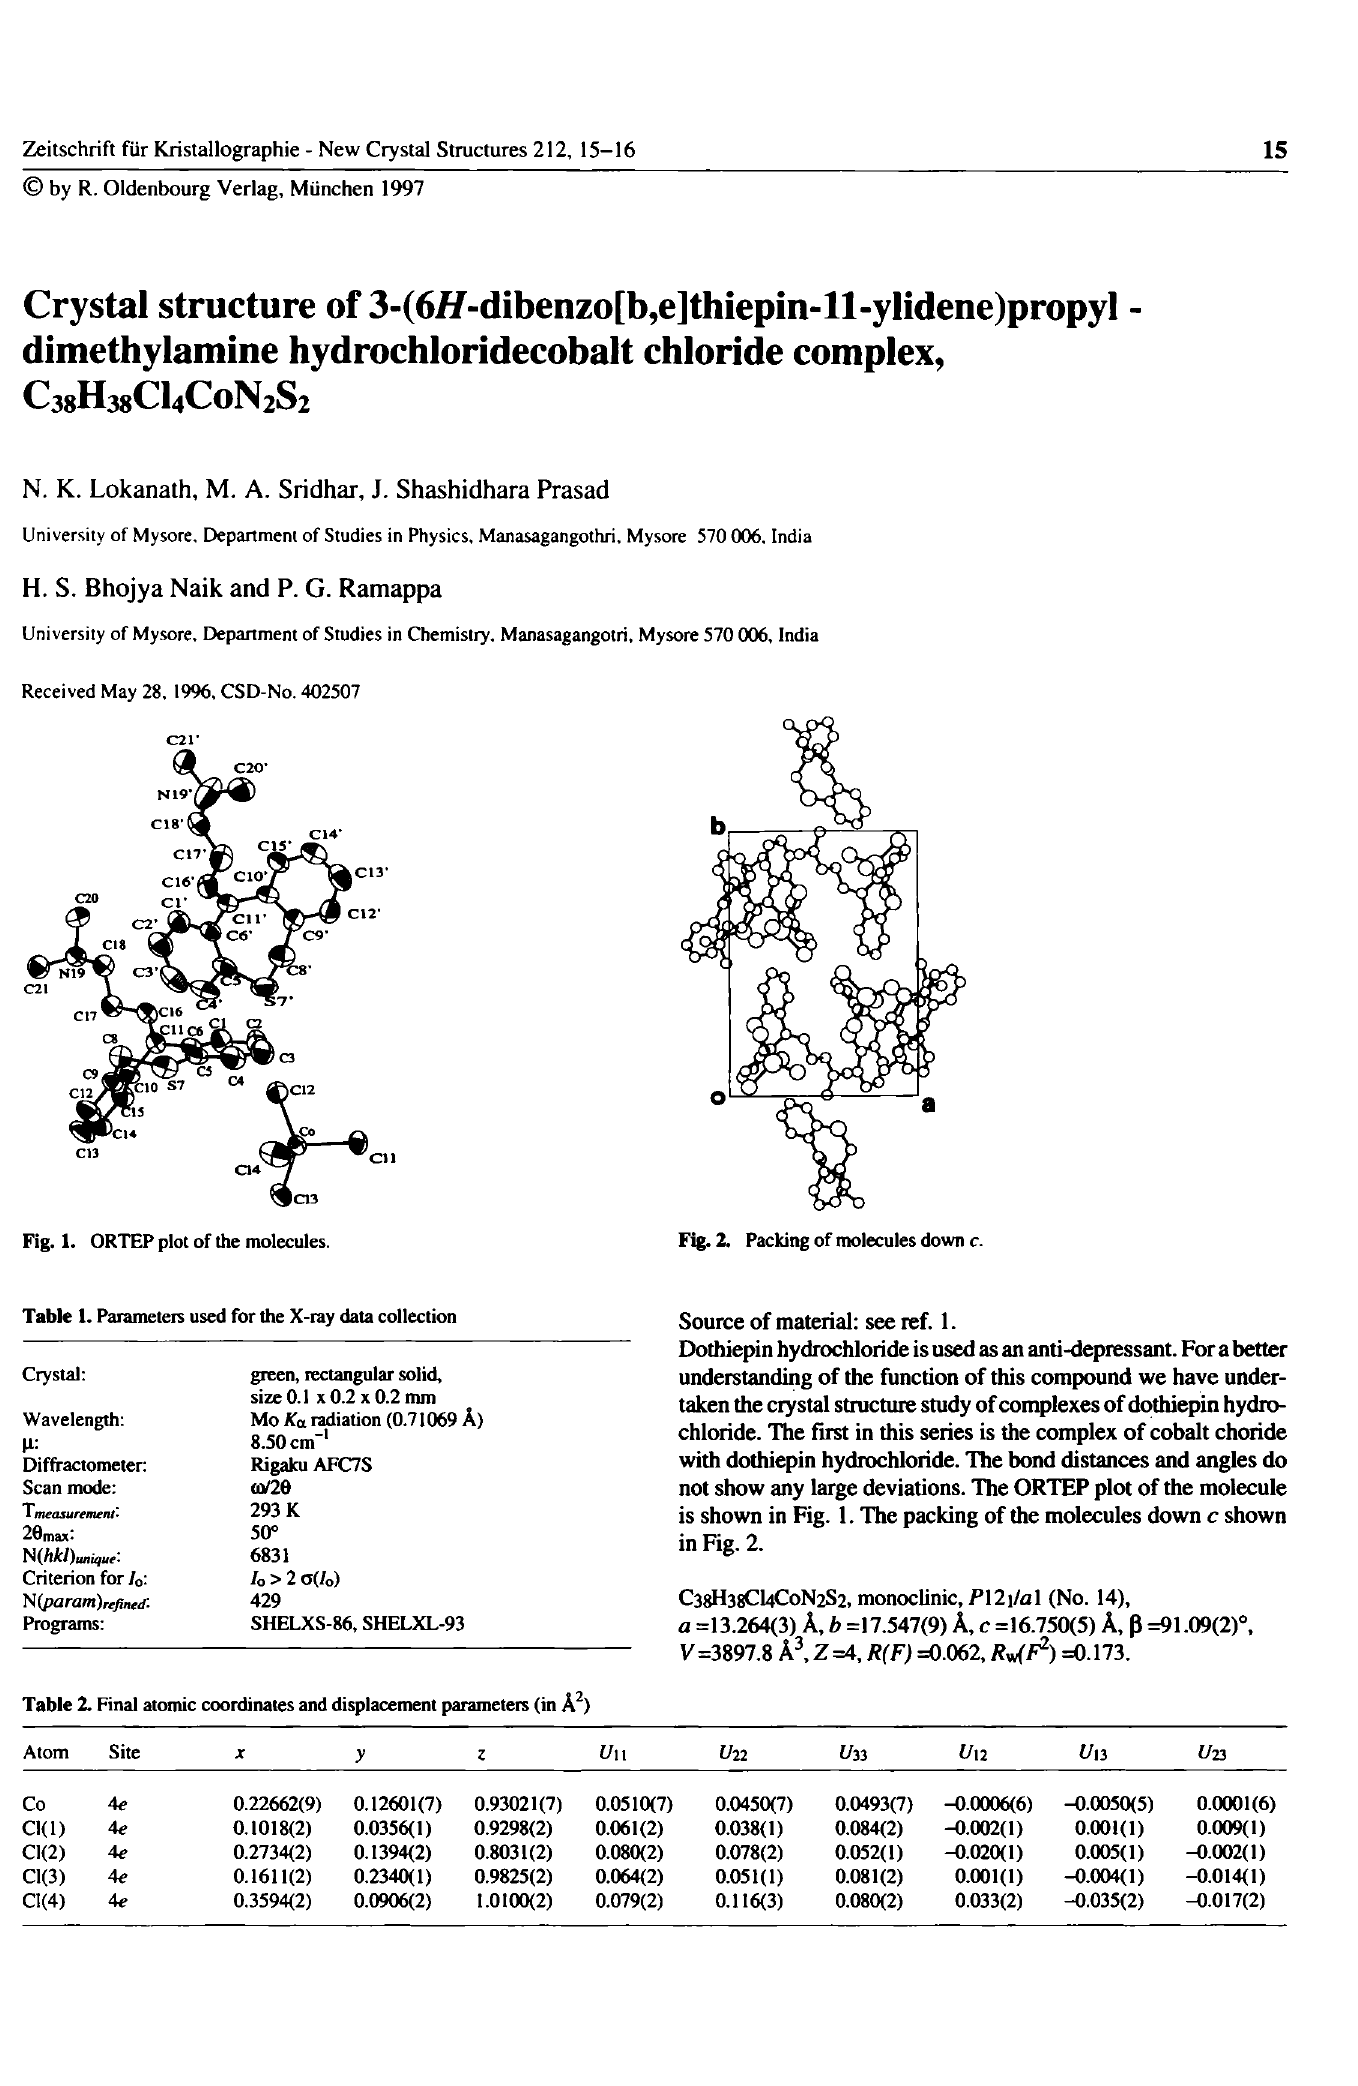
Table 2. Final atomic coordinates and displacement parameters (in Â 2 )